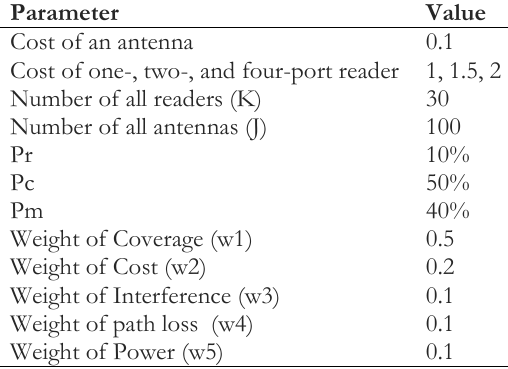
Table 6. RNP model